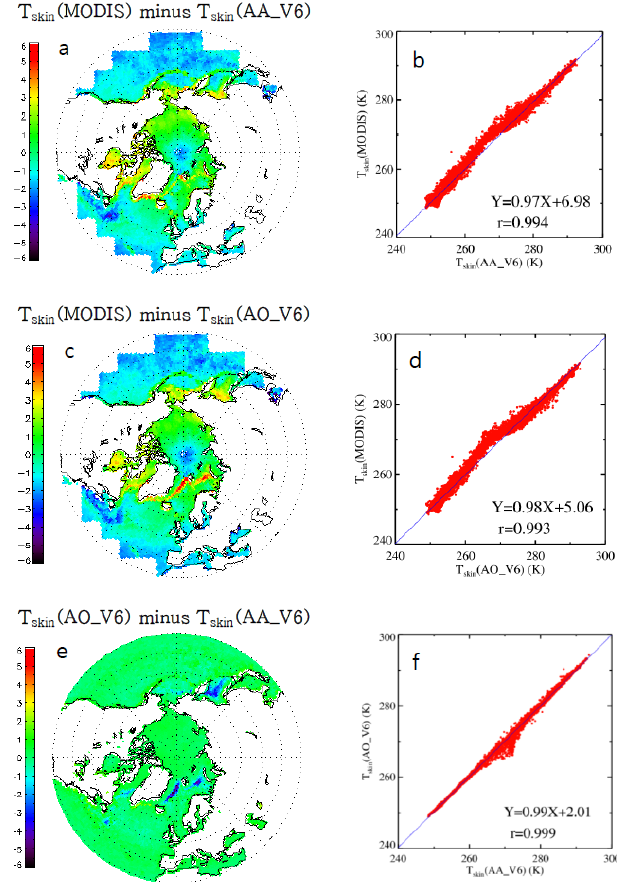
better agreement in the range greater than 280 K was also shown.